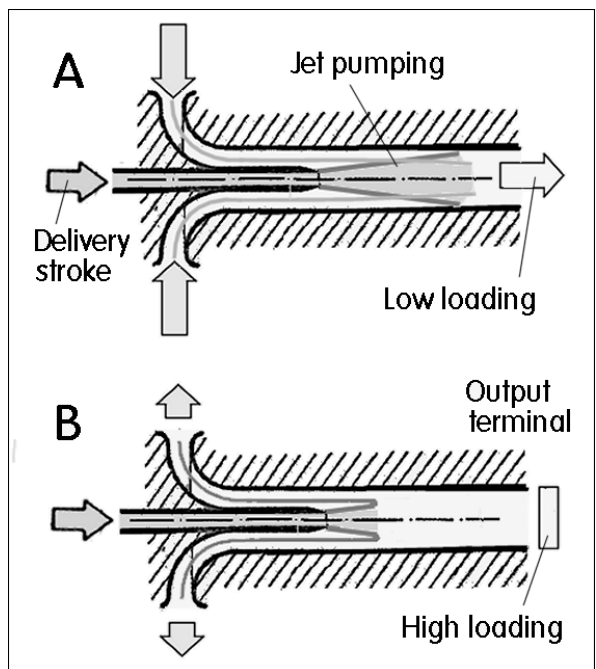
Figure 2. Schematic representation of the rectifier internal flows during the delivery stroke. In the low loading case A, the large output terminal flow rate is due to the jet’s pumping effect. With the output terminal blocked by the load, as in B, the return flow is limited by directing the flow past the sharp edge of the nozzle exit.